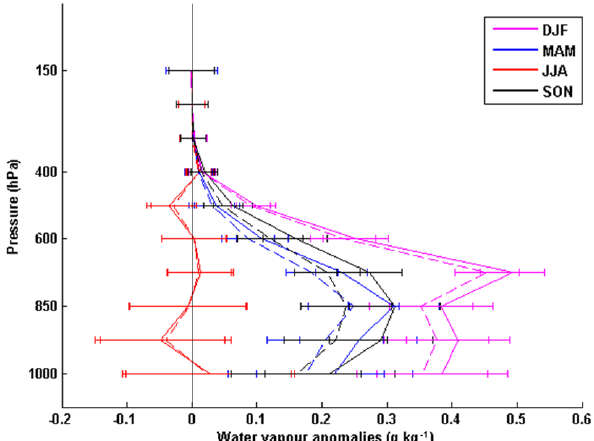
Figure 11. Vertical anomalies of specific humidity (gkg − 1 ) during extreme events with horizontal bars showing standard deviations. The solid lines show anomalies under partially cloudy retrievals and dashed lines are based on cloud-screened